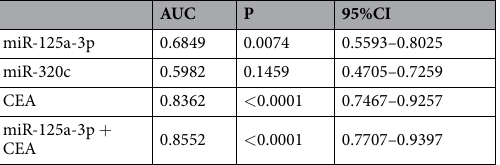
Table 3. Diagnostic power of each marker for early-stage colon cancer. AUC = Area Under the ROC curve. CI = Confidence Interval.